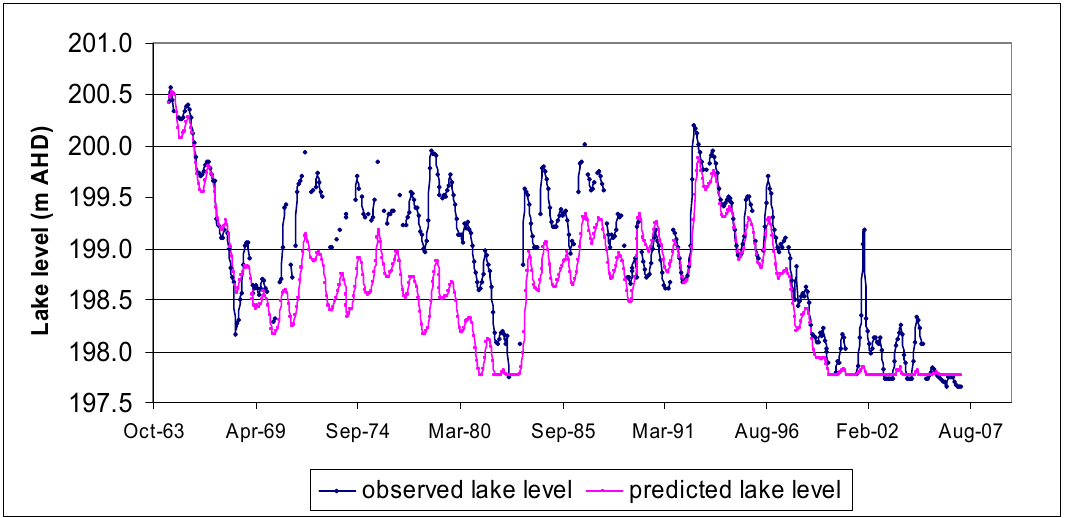
Figure 16. Observed and simulated lake level (deactivating the groundwater node from the model).